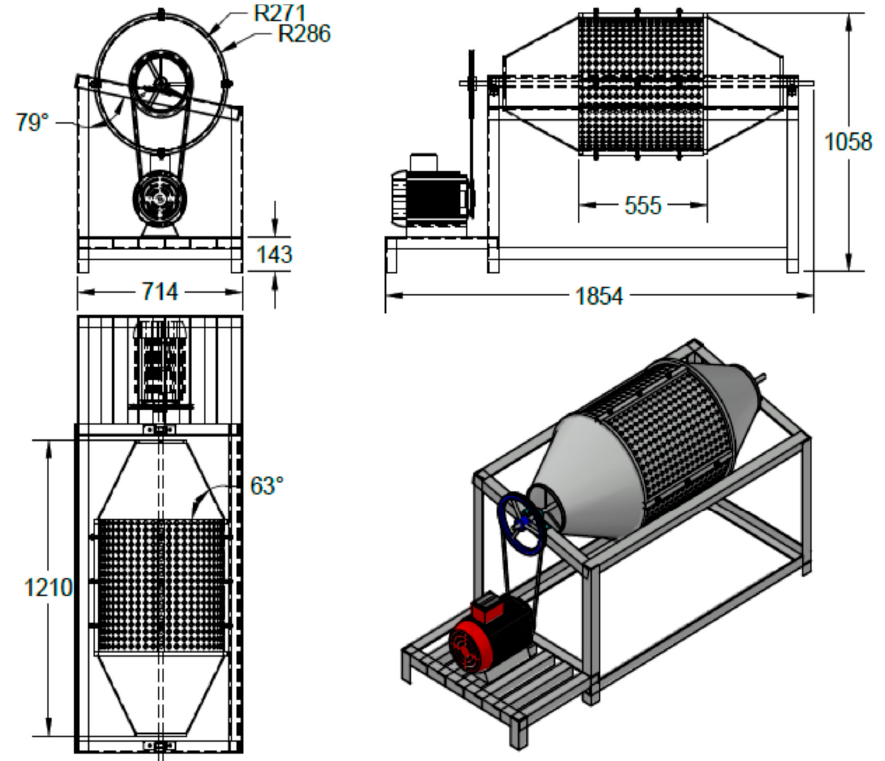
Figure 4. Isometric and orthographic projections of the tuber-peeling machine.